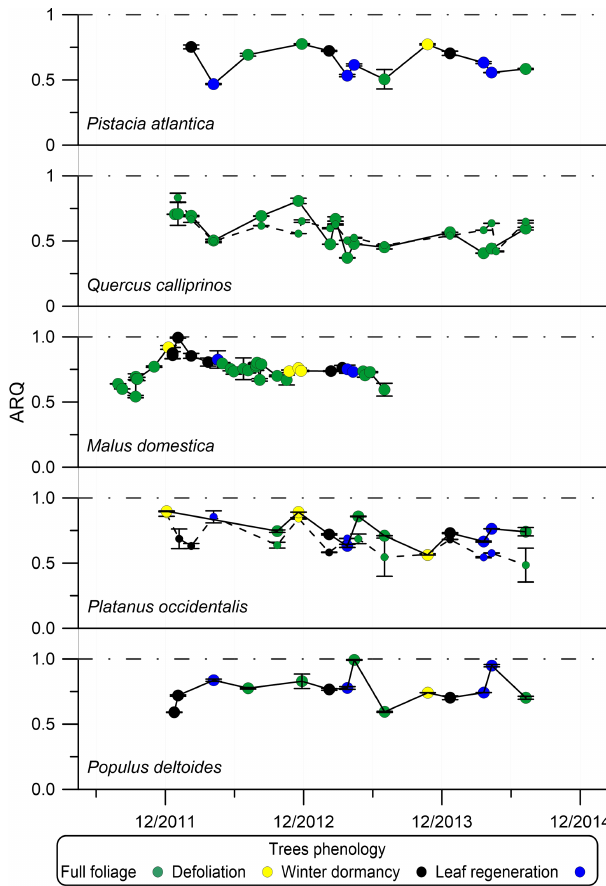
Figure 4. Seasonal dynamics of steady-state ARQ (ratio of CO 2 efflux / O 2 influx for tree stems) of five individual trees from five different species. Phenology stage index determined according to “defoliation” – from beginning of autumn color development to the end of the fall, “winter dormancy” – when the tree was bare from leaves, and “leaf regeneration” – from bud burst to early leaf development stage. The Q. calliprinos is evergreen. Markers are mean values and error bars are SD of duplicate samples from the same stem chamber. Markers connected with solid lines represent measurements with chambers at breast height ( ∼ 1 . 3m above soil surface). Smaller markers connected with dashed lines represent measurements with chambers positioned at the stem base. The trees grew on the Hebrew University campus in Jerusalem, Israel.